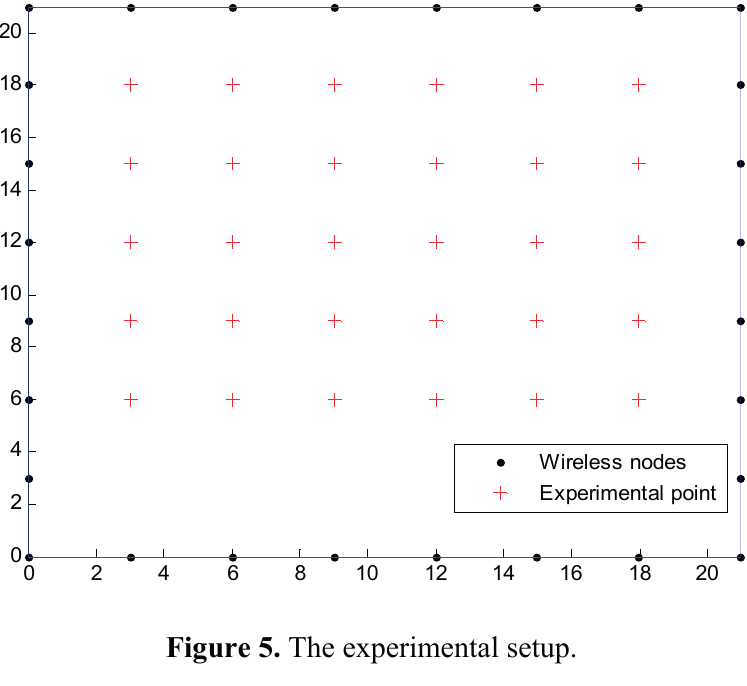
Figure 5. The experimental setup.